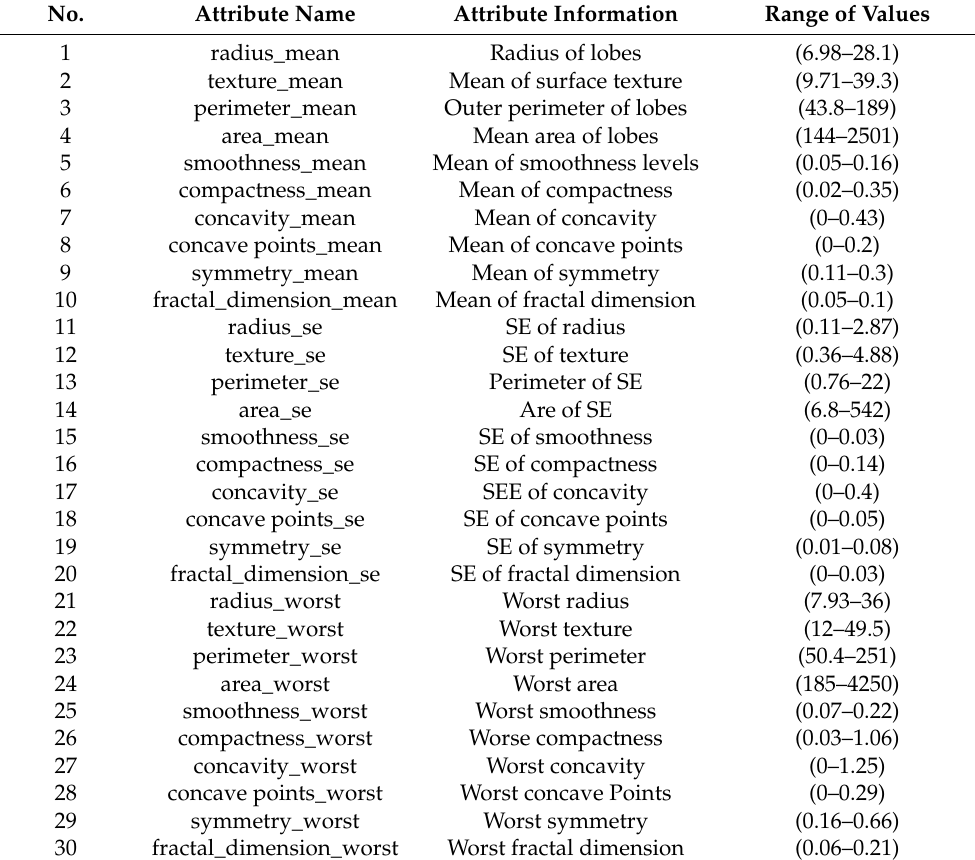
Table 5. Dataset description of breast